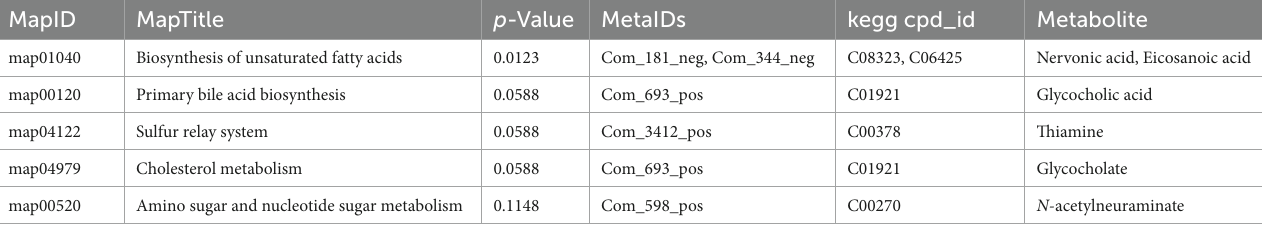
TABLE 2 Kyoto encyclopedia of genes and genomes (KEGG) enrichment results. MapID